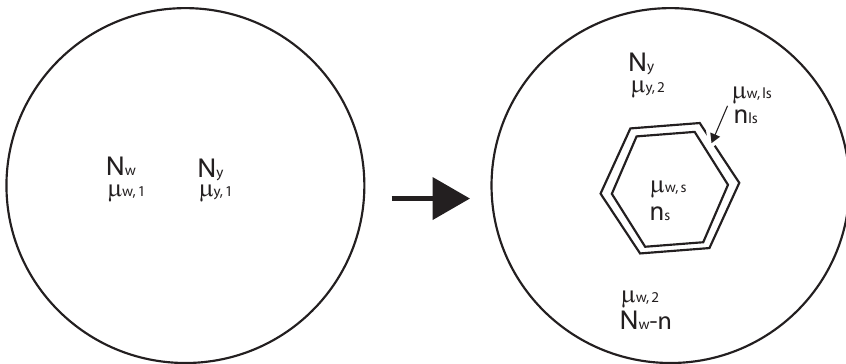
Figure 1. Scheme of the formation of an ice germ from a liquid phase. Subscripts 1 and 2 represent the state of the system before and after germ formation, respectively. N w and N y represent the total molecular concentration of water and solute in the system, respectively. The subscripts ls and s refer to the liquid-solid interface and solid phases, respectively.